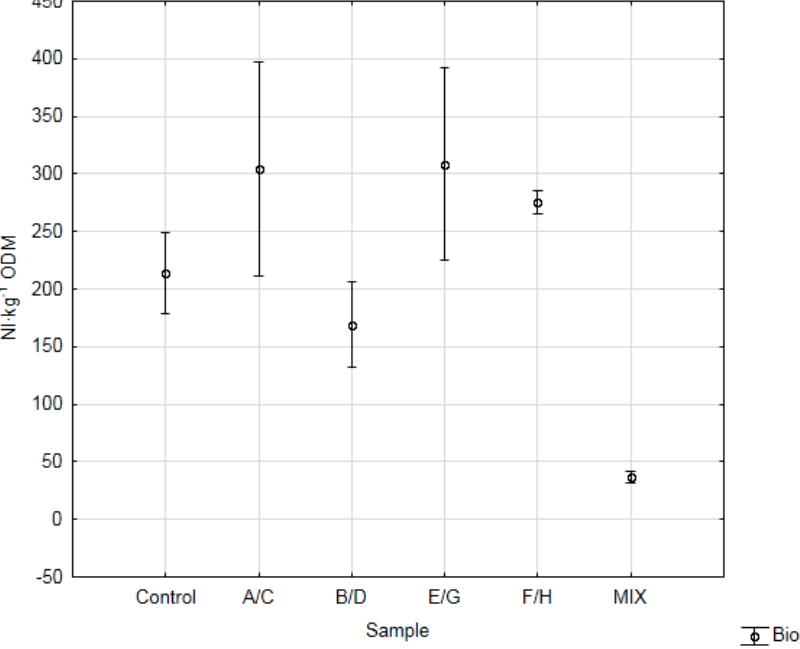
Figure 4. Graphical interpretation of variance analysis results for the biogas yield in tested samples.